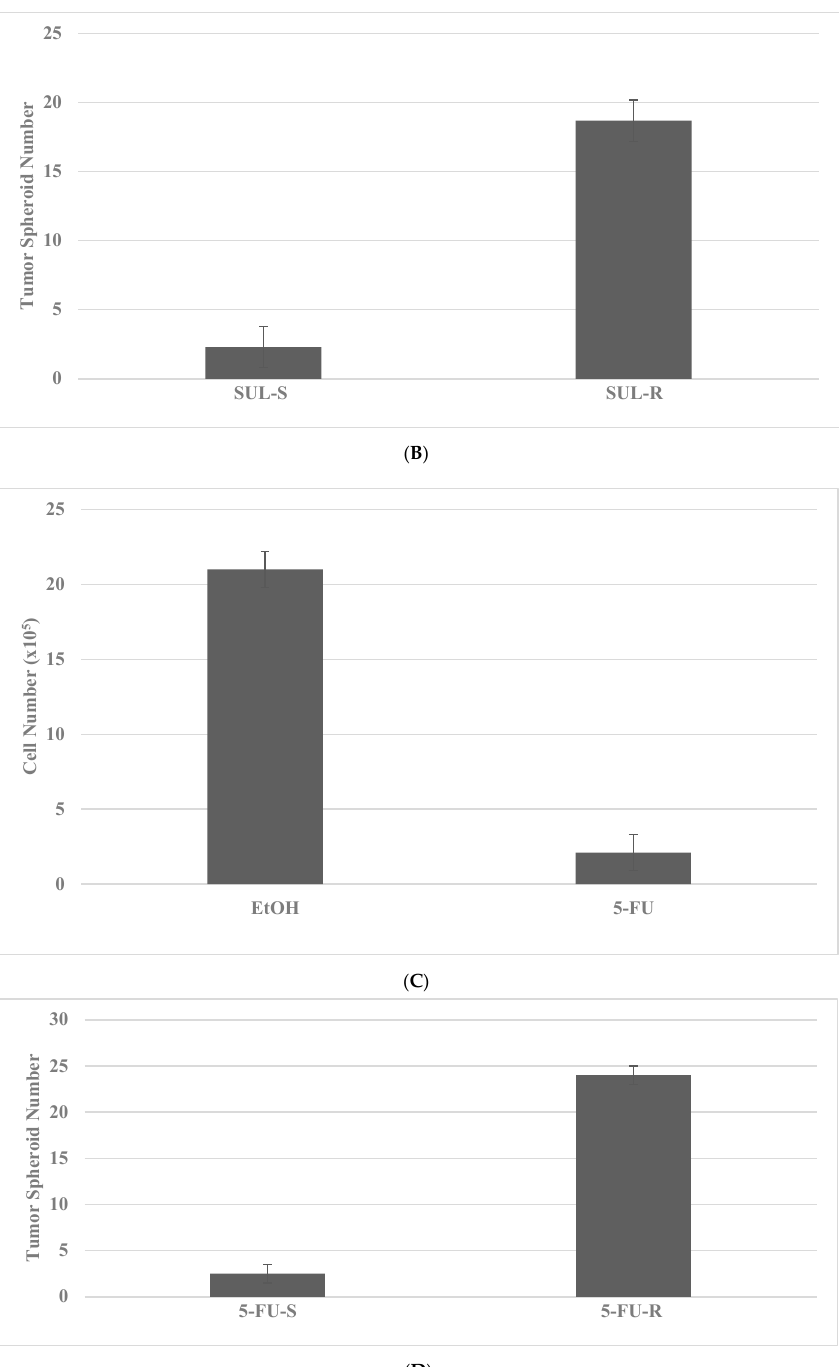
Table 5. Marker expression in breast and colon cancer stem cell models. Organ Type